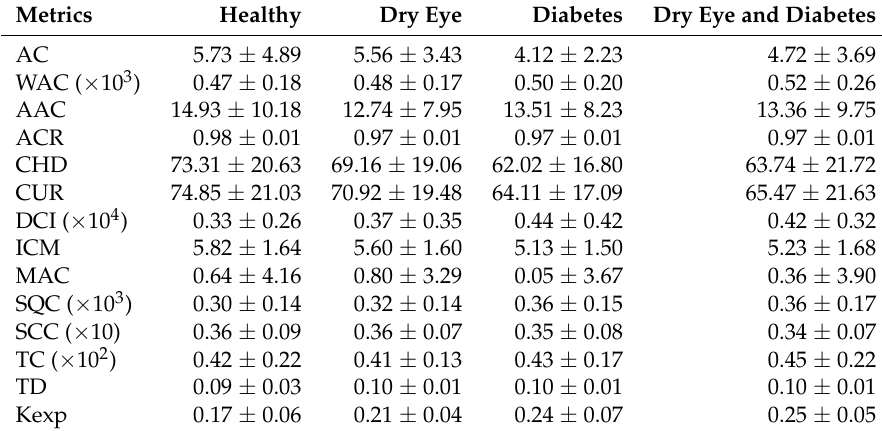
Table 4. Different metrics in control subjects and other diseases